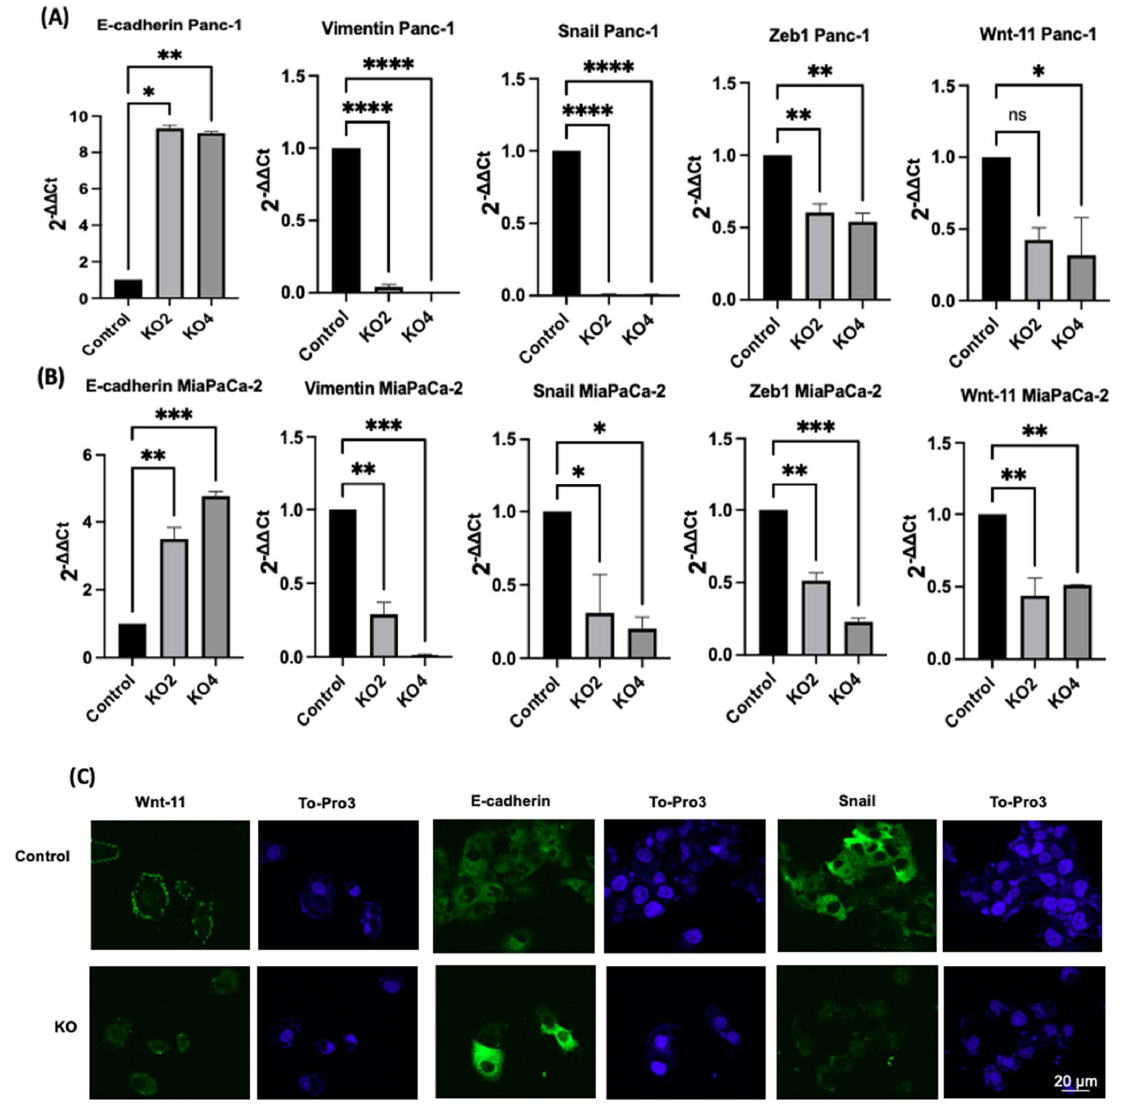
Figure 3. The silencing of miR-21 reduced the mesenchymal phenotype of PDAC cells. ( A ) E-cadherin, Vimentin, Snail, Wnt-11, and Zeb1 in the Panc-1 cell line relative mRNA expression levels. Relative mRNA expression levels of Vimentin, Snail, and Zeb1 were significantly downregulated in miR-21 KO2 and KO4 in the Panc-1 cell line, while E-cadherin was significantly upregulated. Relative mRNA expression levels Wnt-11 were significantly reduced in miR-21 KO4 but not in miR-21 KO2 in the Panc-1 cell line. The column graphic represents the average of three replicates of RNA isolated from Panc-1 control and its Kos. Data normalized according to RNA polymerase II (RPII) expression by fold analysis ( n = 3, p < 0.05). ( B ) Relative mRNA expression levels of E-cadherin, vimentin, Snail, Wnt-11, and Zeb1 in the MiaPaCa-2 cell line. Relative mRNA expression levels of vimentin, Snail, Zeb1, and Wnt-11 significantly decreased in miR-21 KO2 and KO4 in the MiaPaCa-2 cell line, while E-cadherin significantly increased. The column graphic represents the average of three replicates of RNA isolated from MiaPaCa-2 control and its Kos. Data normalized according to RNA polymerase II (RPII) expression by fold analysis ( n = 3, p < 0.05). Exact p -values are indicated (* p ≤ 0.05; ** p ≤ 0.01; *** p ≤ 0.001; **** p ≤ 0.0001); error bars indicate SD. ( C ) Immunofluorescence assays were performed to show Wnt-11, E-cadherin, Snail protein levels, and protein localization (green) in Panc-1 wt (Control) and miR-21 KO cells. To-Pro3 (blue) was used for staining nuclei. KO2 immunofluorescence results are shown as a representative to compare to control ( n = 3), the scale bar represents 20 µ m in all